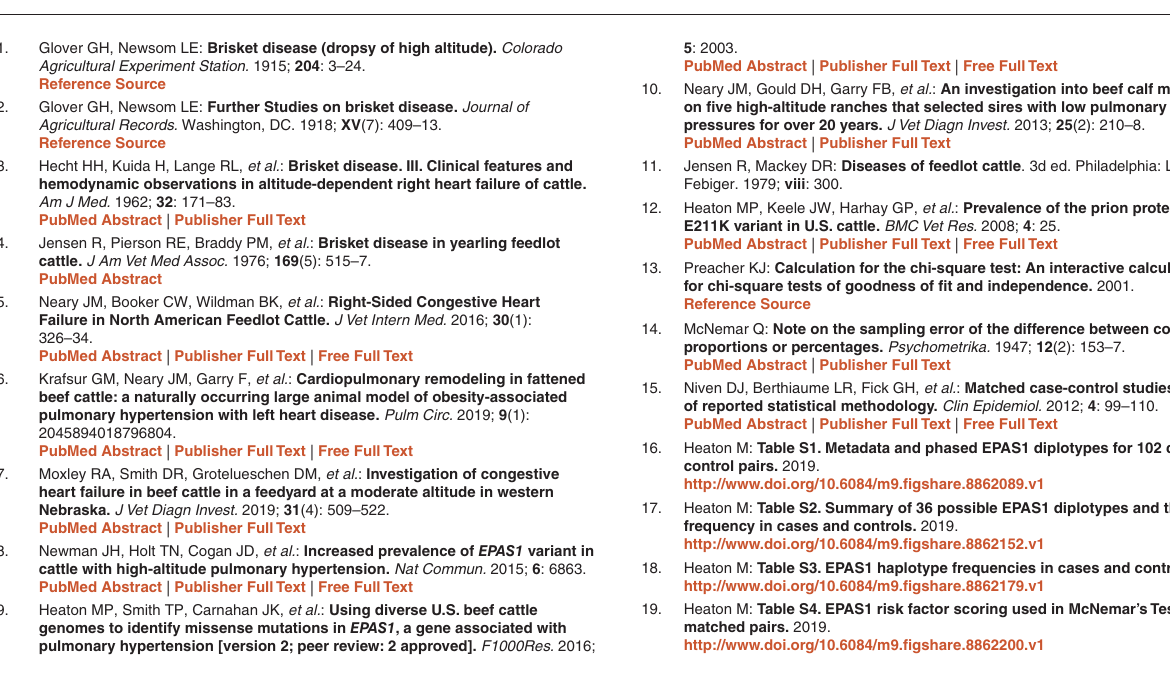
Figshare: Table S1. Metadata and phased EPAS1 diplotypes for 102 case-control pairs. https://doi.org/10.6084/m9.figshare. 8862089.v1 16